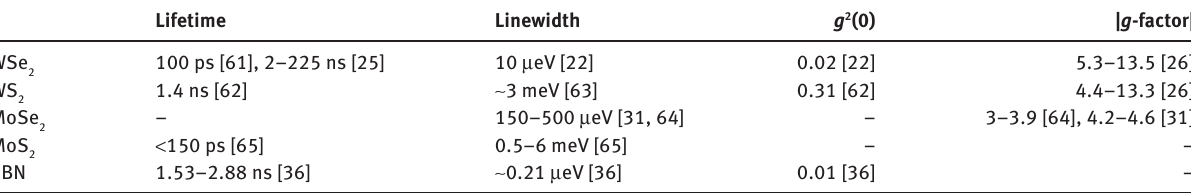
Table 1: Comparison of experimental values of emission lifetime, linewidth, g 2 (0), and g -factor values of localized emitters in different monolayer